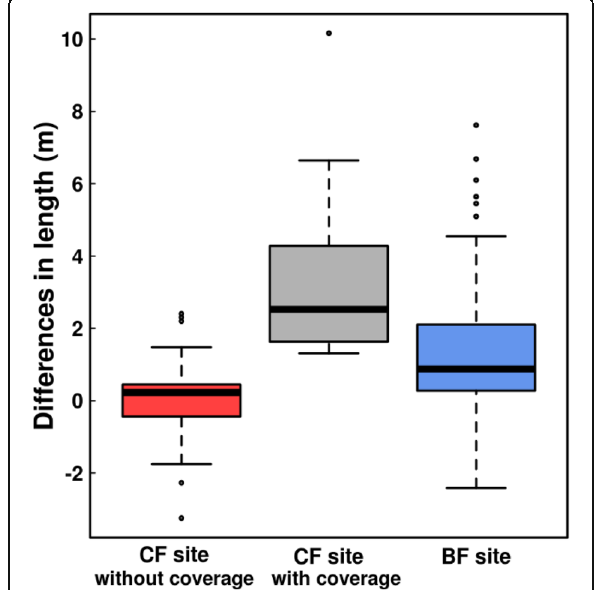
Fig. 5 Boxplot of differences between the extracted and measured lengths of the wood pieces. Differences in length were calculated by subtracting the extracted length from the measured length